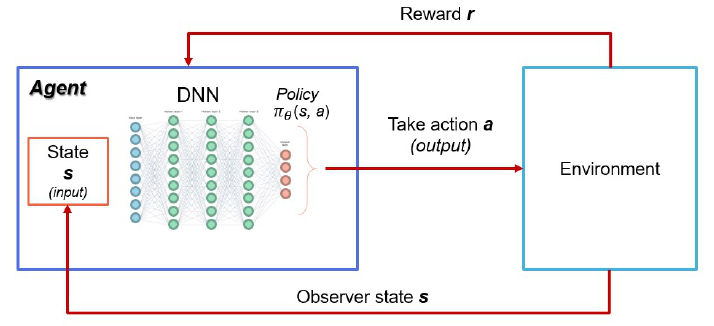
Figure 5. Deep Q-Learning